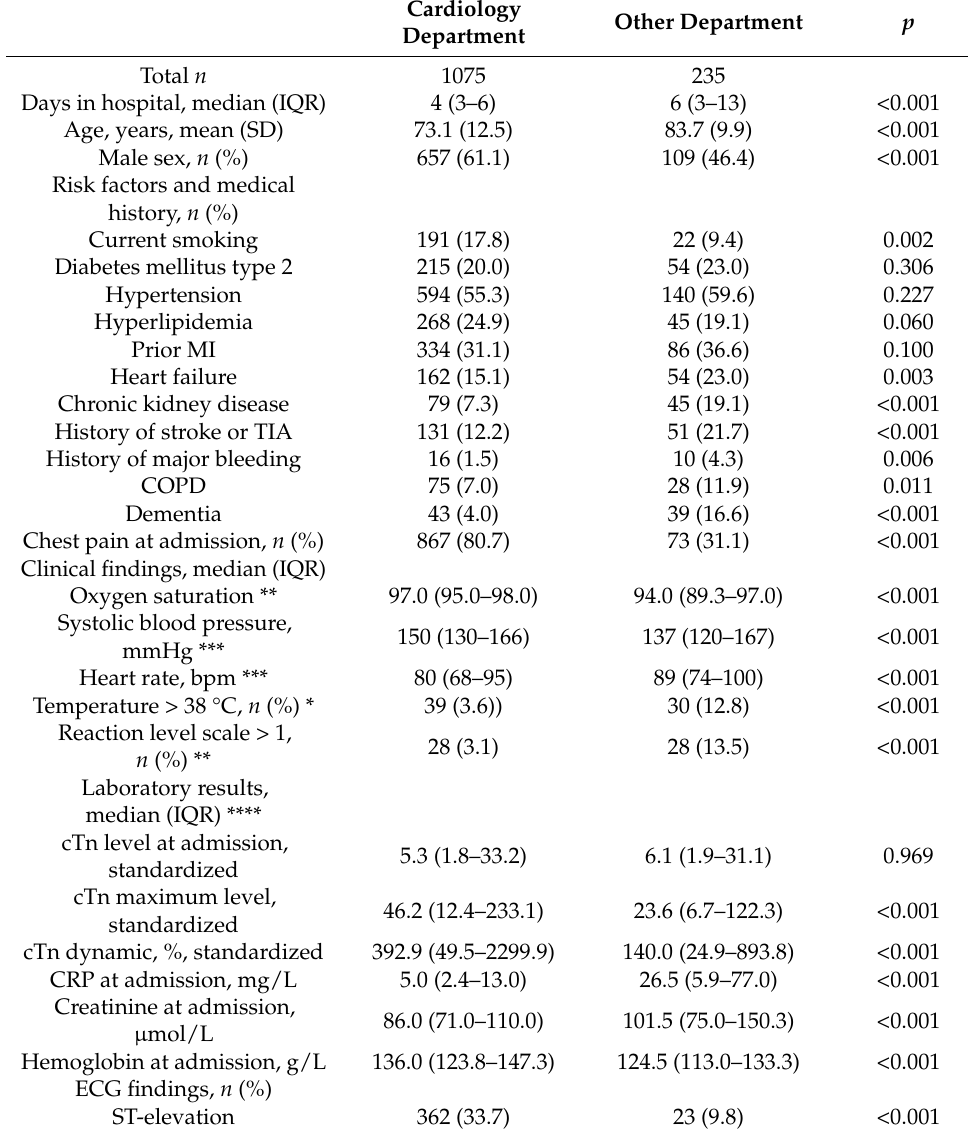
Table 2. Patient